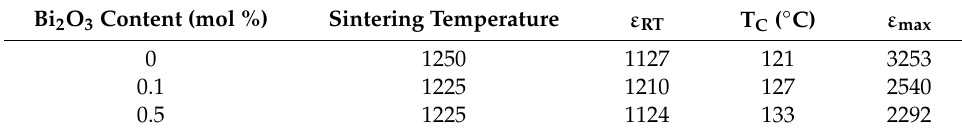
Table 2. Dielectric constant at room temperature ( ε RT ) and its maximum value ( ε max ) at Curie temperature (T C ) measured at 1 kHz for BaTiO 3 ceramics with different Bi 2 O 3 contents. Bi 2 O 3 Content (mol